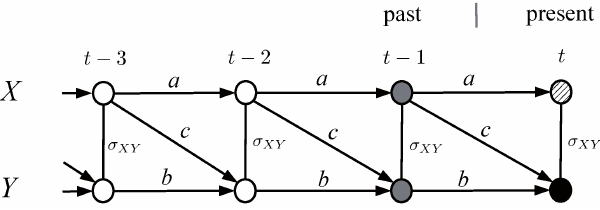
Fig. 5. Representation of the time series graph of the simple coupled bivariate process ( X t , Y t ) in Eq. (1) with the constant coefficients a , b and c . σ XY is the non-diagonal element of the covariance matrix. Process Y t (black node) is driven by Y t − 1 and X t − 1 (in grey) and has a contemporaneous link to X t (hatched). Due to stationarity, the same causal relation holds for all t .